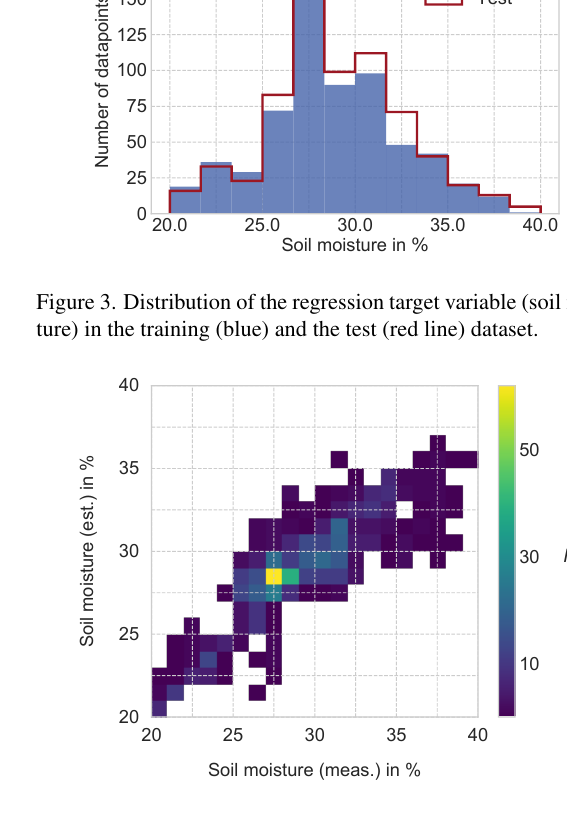
Figure 4. Example of a 2-dimensional histogram of the ET re- gressor showing the estimated vs. the measured soil-moisture values. N represents the number of datapoints in the